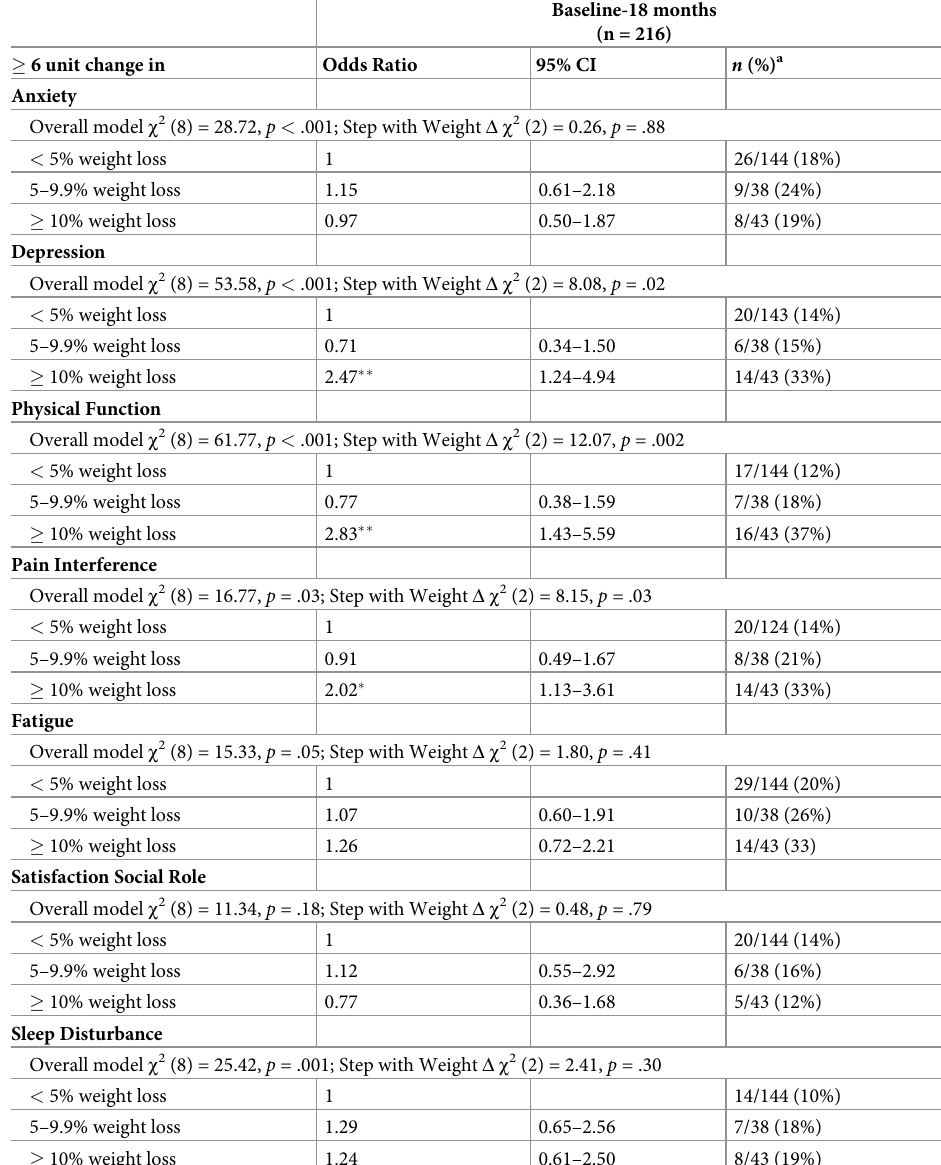
Table 4. Association between categorical change in weight and change in PROMIS-29 v 1. over 18 months.